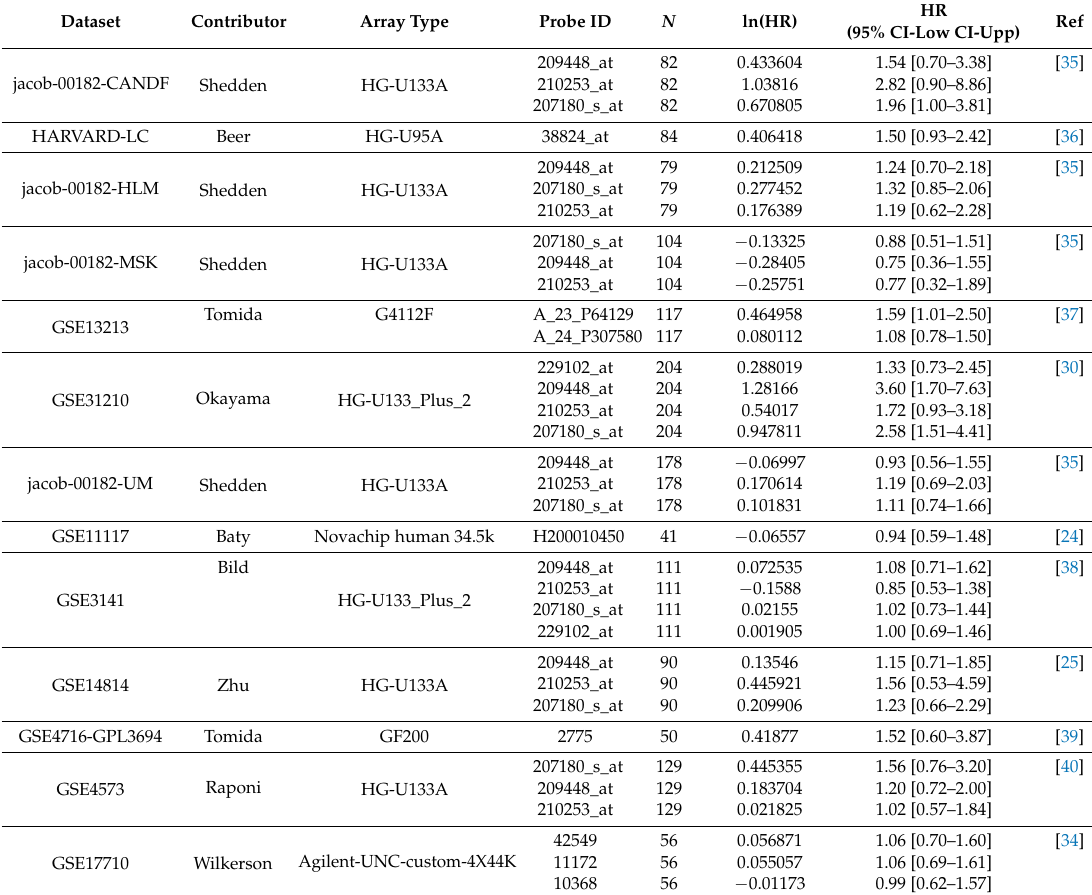
Table 2. Association of TIP30 expression and overall survival in lung cancer patients from the PrognoScan